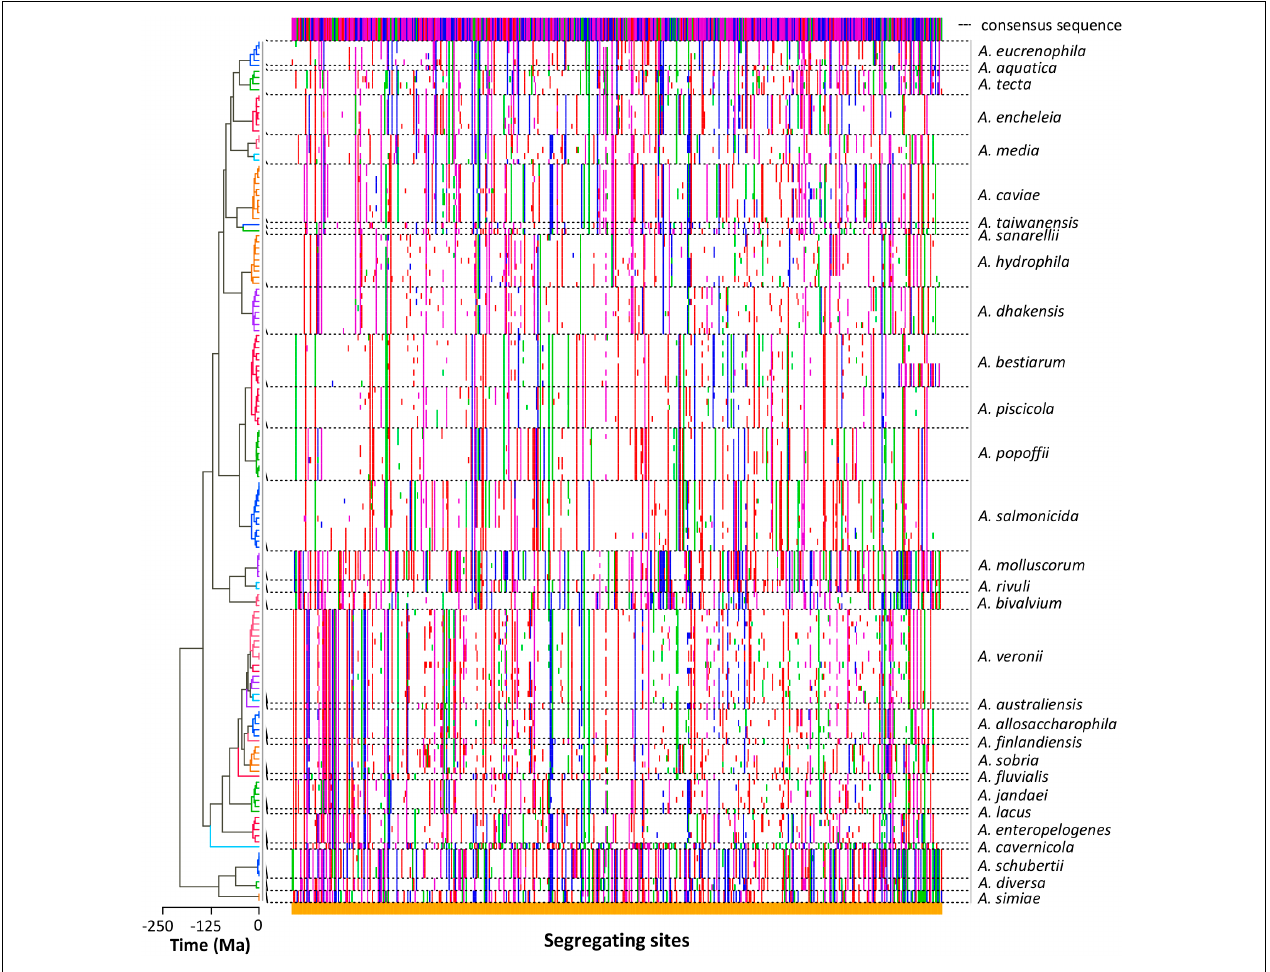
FIGURE 3 | Sequence polymorphism. The dots plot shows the segregating sites determined in each sequence arranged in the same order as in the tree (left) . Polymorphic differences between the sequences and the consensus sequence (top) are marked in colors depending on the base (A green, G blue, C purple, T red). Dashed lines delimit the sequences belonging to the same Aeromonas